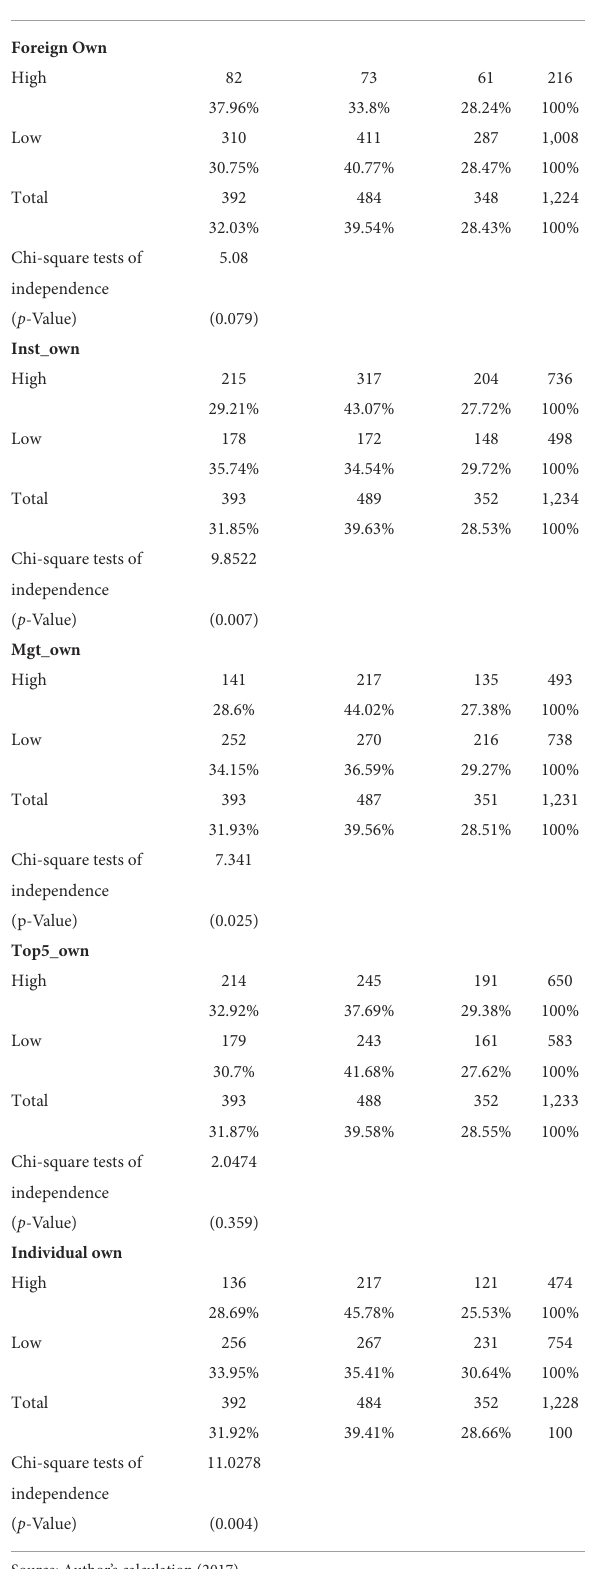
TABLE 10A Owner structure and Frequency of dividend changing events. Panel: